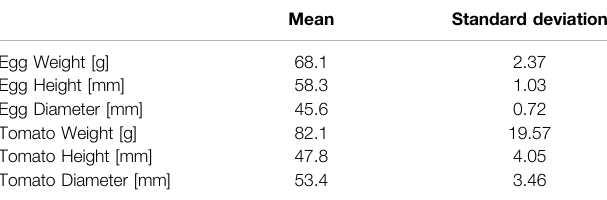
TABLE 1| Table showing the distribution of sizeand weight ofthe products used.